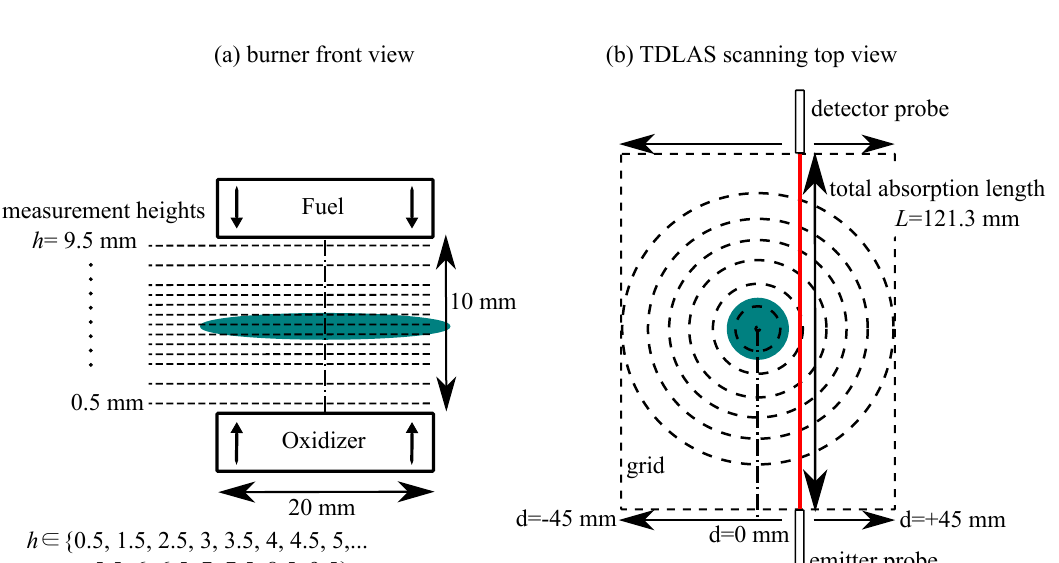
Figure 1. Burner configuration and scanned TDLAS setup. For illustration purposes the N = 40 grid rings for the reconstruction are represented by just 7 equidistant rings. The centered high temperature region is marked as green